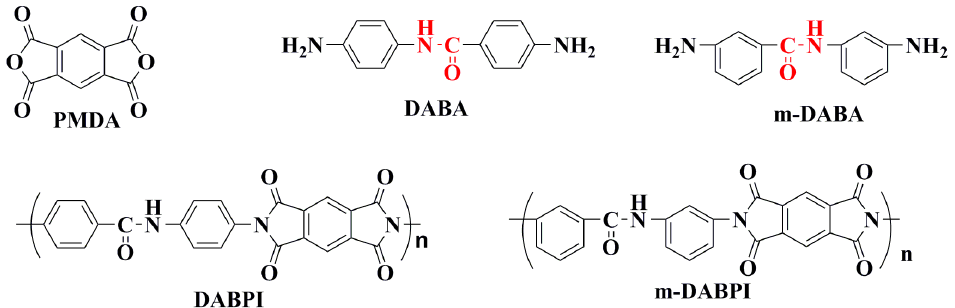
Figure 1. The chemical structure of PMDA, DABA, 3-amino-N-(3-aminophenyl)benzamide (m- DABA),4-methyl-N-(4-(6-methyl-1,3,5,7-tetraoxo-3,5,6,7-tetrahydropyrrolo[3 ,4-f]isoindol-2(1H)- yl)phenyl)benzamide (DABPI), and 3-methyl-N-(3-(6-methyl-1,3,5,7-tetraoxo-3,5,6,7-tetrahydro- pyrrolo[3,4-f]isoindol-2(1H)-yl)phenyl)benzamide